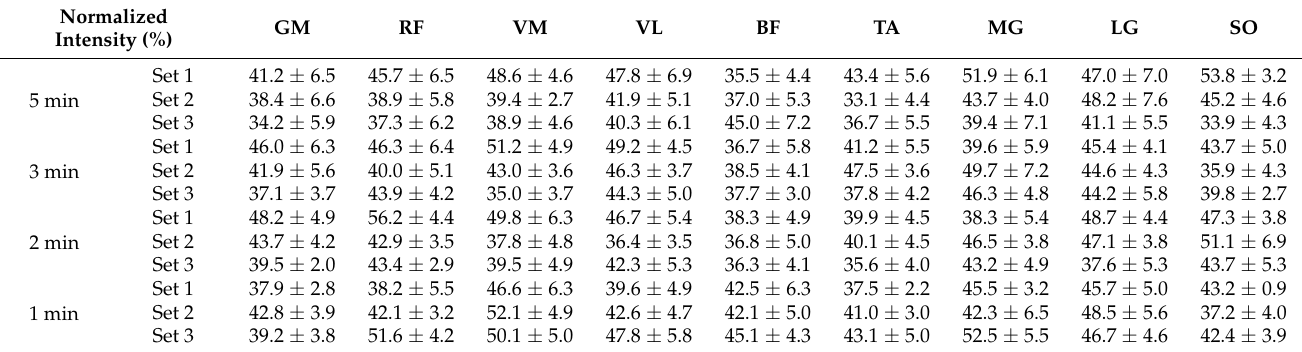
Table note: GM: gluteus maximus; RF: rectus femoris; VM: vastus medialis; VL: vastus lateralis; BF: biceps femoris; TA: tibialis anterior; MG: medial gastrocnemius; LG: lateral gastrocnemius; SO: soleus.